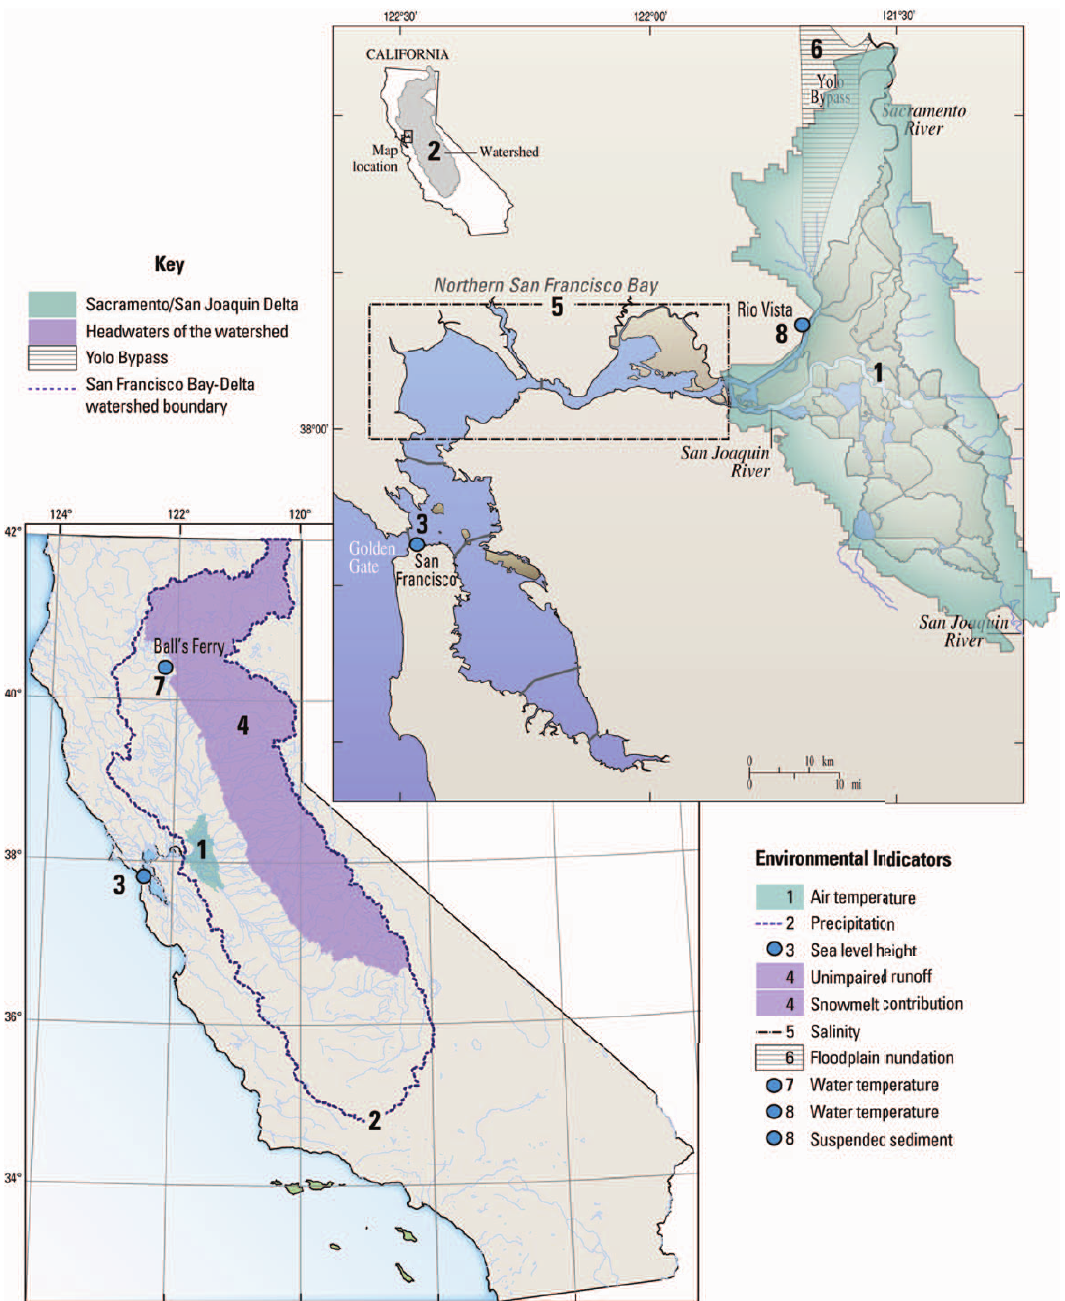
Figure 1. Spatial domains of environmental indicators. Shaded or hatched areas represent spatial domains of indicators representing areal averages or pertaining to a broad area, and blue dots represent locations of indicators corresponding to specific sites. Key shows geographic descriptions, and legend on lower-right shows corresponding indicators; compare to Figs. 2–3 and Table 1.